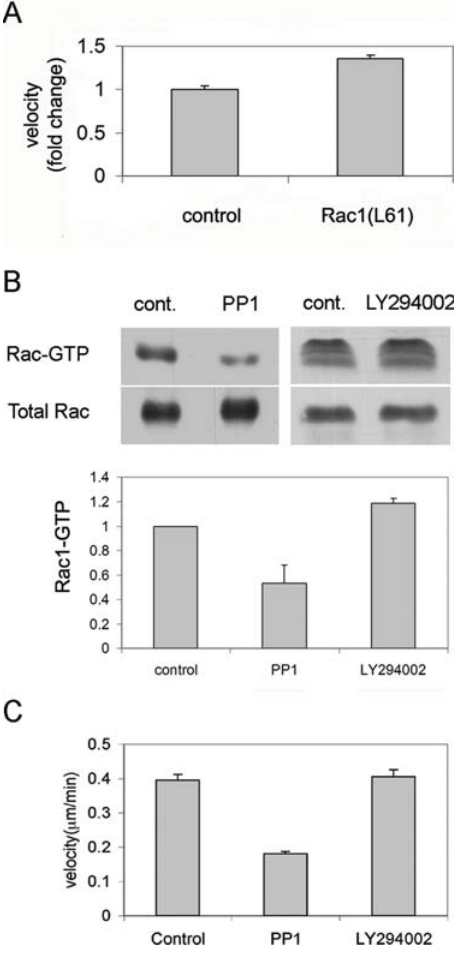
Figure 6. Src dependent Rac1 activity is essential for cell motility. A. Late HF1 cells were transfected with active Rac1 (Rac1L61) or with GFP as control. Cell motility movies were created by acquiring live-cell images every 15 min throughout 5 h of the experiment. Cell velocity was calculated by marking the cell nucleus in every frame, and following cell movement. Average velocity was calculated by an application within the UCSF PRIISM environment ((http://msg.ucsf.edu/ ive). Graph shows fold change in velocity, normalized to the control cells. Errors represent standard error of . 100 cells. B. Primary keratinocytes were treated with 5 m M PP1 or 5 m M LY294002 for 4 h before cell lysis and Rac1 activity assay. Graphs show quantification of Rac1-GTP. Error bars represent standard deviations of two experiments. C. Quantification of cell motility in the presence of PP1 or LY294002. Migration rate was examined as in A. Error bars represent standard error of . 50 cells.